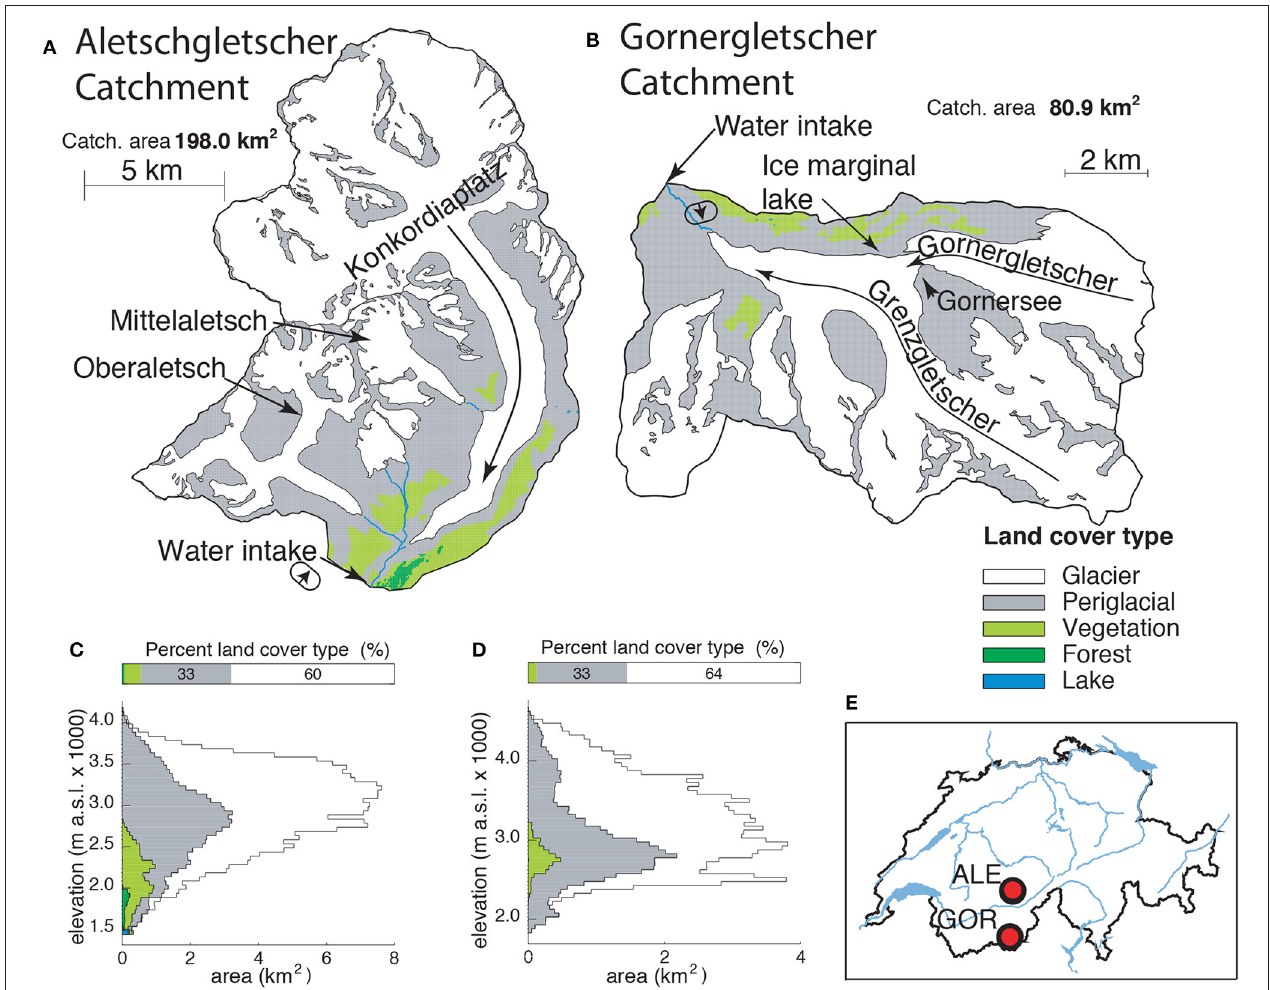
FIGURE 1 | Maps, land cover and hypsometry for Aletschgletscher catchment (A) and Gornergletscher catchment (B) located within Switzerland (E) . Water intakes that house instrumentation are labeled, as are the ice marginal lake and Gornersee in the Gornergletscher catchment. Interpreted glacier flow lines are marked. (C,D) Represent hypsometry for the Aletschgletscher and Gornergletscher catchments, respectively. Ovals with arrows (A,B) denote the approximate location and directions of photos (A,C) in Figure 2